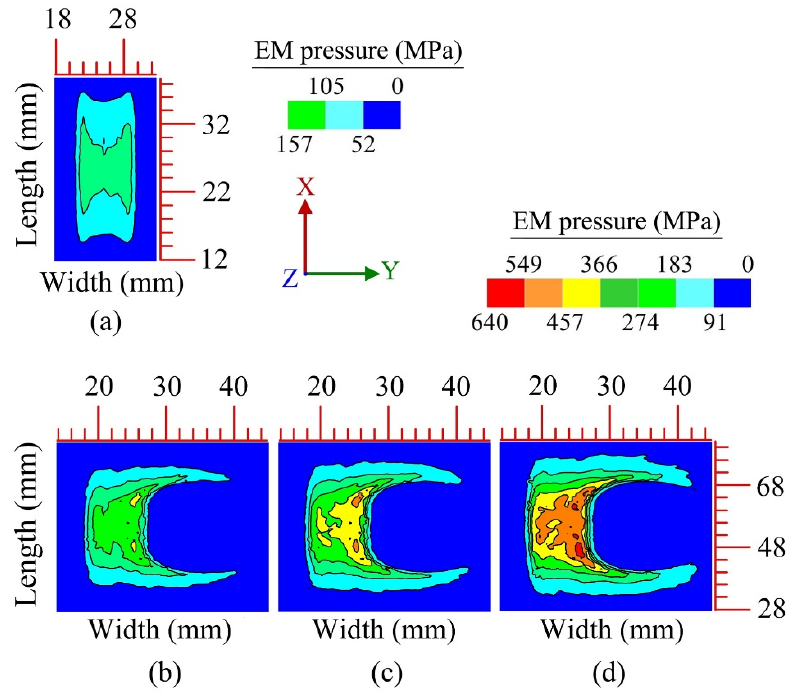
Figure 5. Computed EM pressure distribution on AA5182 aluminium alloy flyer with ( a ) rectangular- and ( b – d ) O-shaped flat coils for applied energy of ( a , b ) 10, ( c ) 13, and ( d ) 16 kJ.